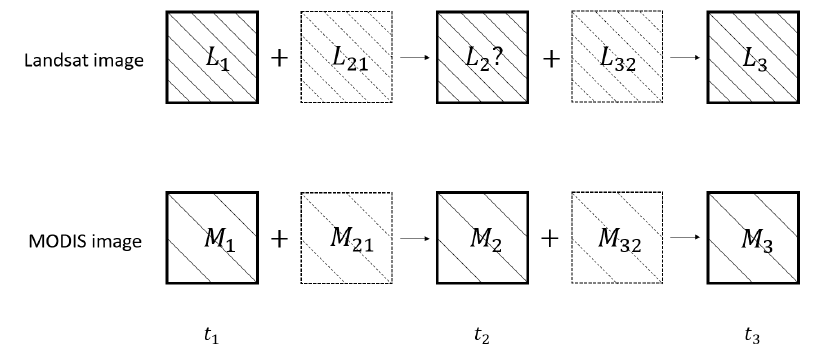
Figure 1. Input images and the target image for spatiotemporal fusion ( t 1 < t 2 < t 3 ). Three low resolution images M 1 , M 2 and M 3 , and two high resolution images L 1 and L 3 are known. The high resolution image L 2 is the target image to be